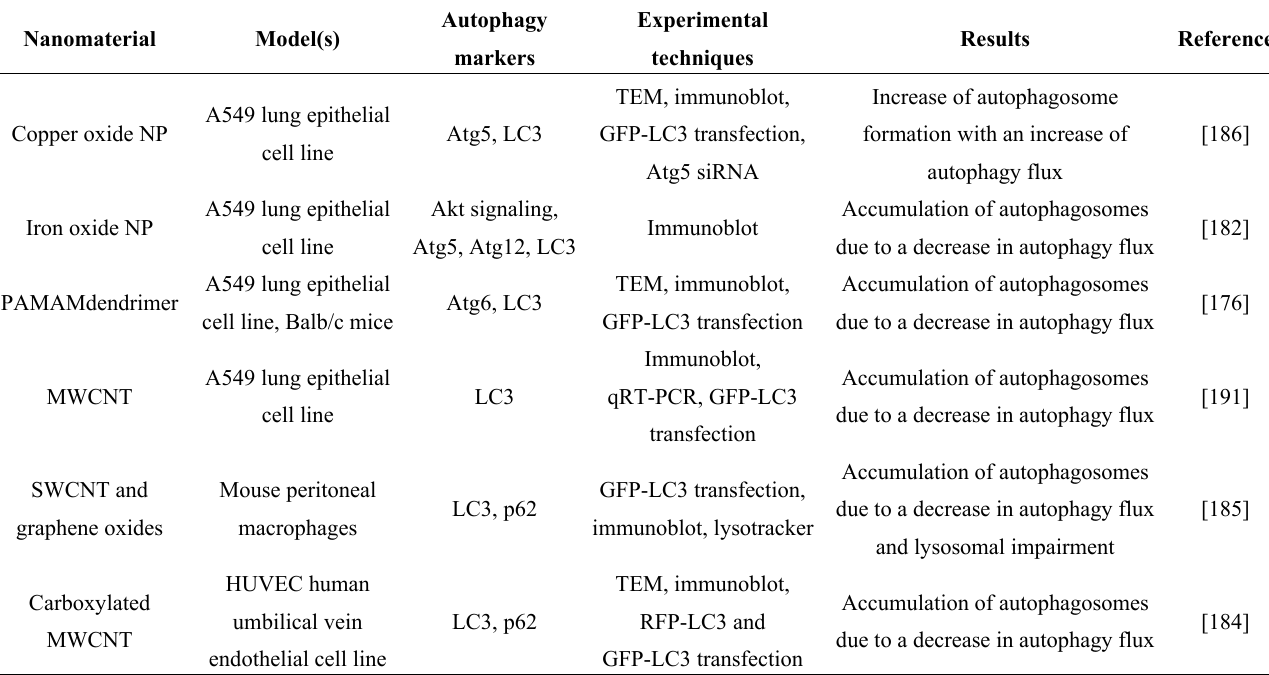
Table 2. A summary of nanomaterial-induced autophagy dysfunction in the literature: focus on modifications of autophagic